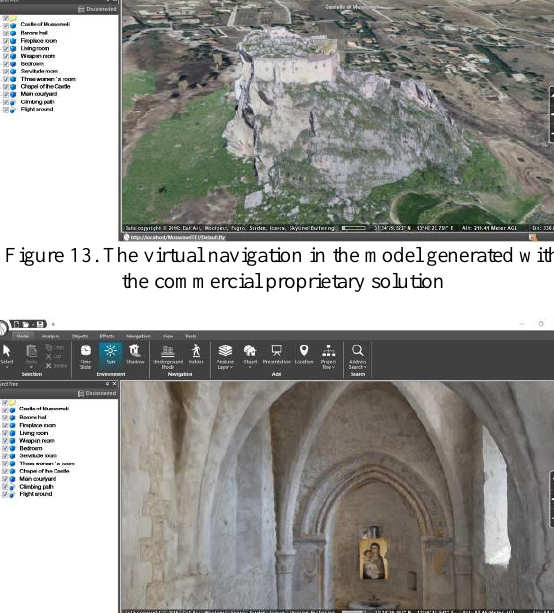
Figure 14. An indoor environment accessed through the commercial proprietary solution